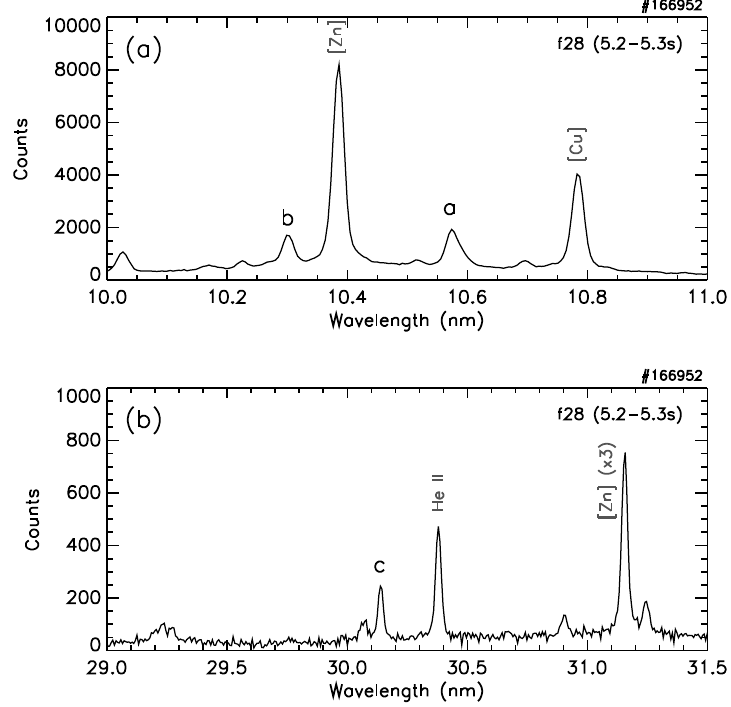
Figure 1. Spectra of europium ( Z = 63) ions observed in high-temperature LHD plasmas in the wave- length ranges ( a ) 10–11 nm and ( b ) 29–31.5 nm, measured by the SOXMOS spectrometer. The lines a , b , and c are transitions of Ga-like ions from ((4s, 4p − ) 1 , 4p + ) 3/2 , ((4s, 4p − ) 1 , 4p + ) 1/2 , and (4p + ) 3/2 , re- spectively, to the ground state (4p − ) 1/2 . The lines of Cu-like and Zn-like europium ions are indicated by square brackets. The measured line broadening mostly comes from the instrumental